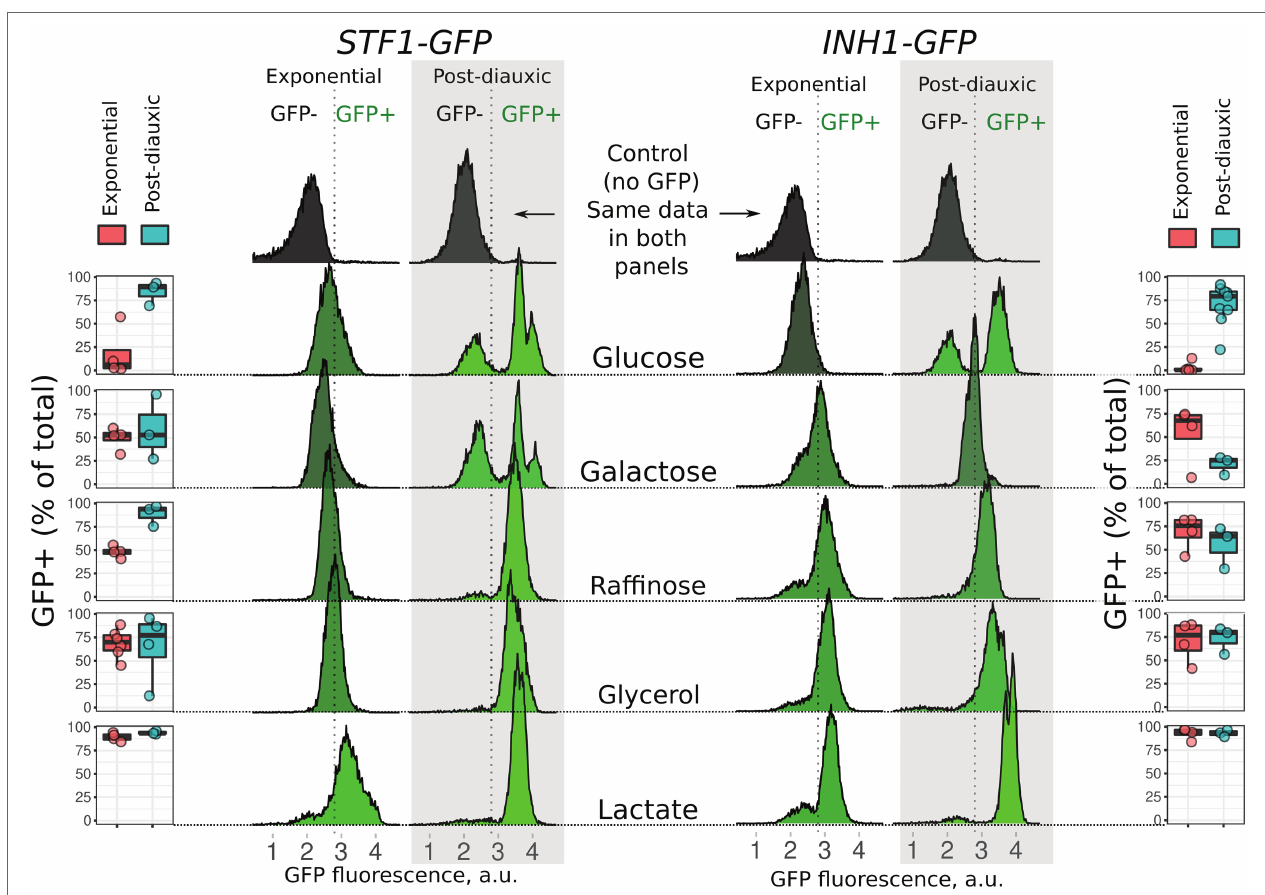
FIGURE 1 | Accumulation of Stf1-GFP (left panel) and Inh1-GFP (right panel) in exponentially growing and post-diauxic BY4741 yeast cells. Boxplots show the proportion of yeast cells with GFP levels above the autofluorescence signal. Histograms show the results of representative experiments. Upper histograms correspond to autofluorescence of the control cells without GFP which are the same for both